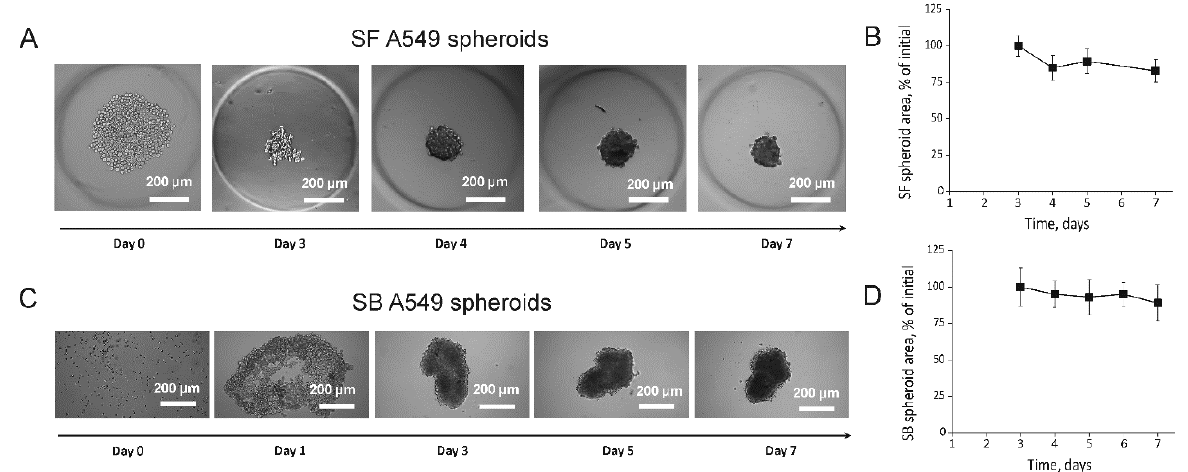
Figure 1. Morphological characteristics of SF and SB A549 spheroids. ( A ) Morphological changes in cultured SF spheroid over time. ( B ) Changes in average area occupied by SF spheroid during a one-week incubation. ( C ) Morphological changes in cultured SB A549 spheroids over time. ( D ) Changes in average area occupied by SF spheroid during a one-week incubation. ( B , D ) Data are shown as means ± SD ( n = 8). Table 1. Characteristics of SB and SF A549 spheroids on day 7